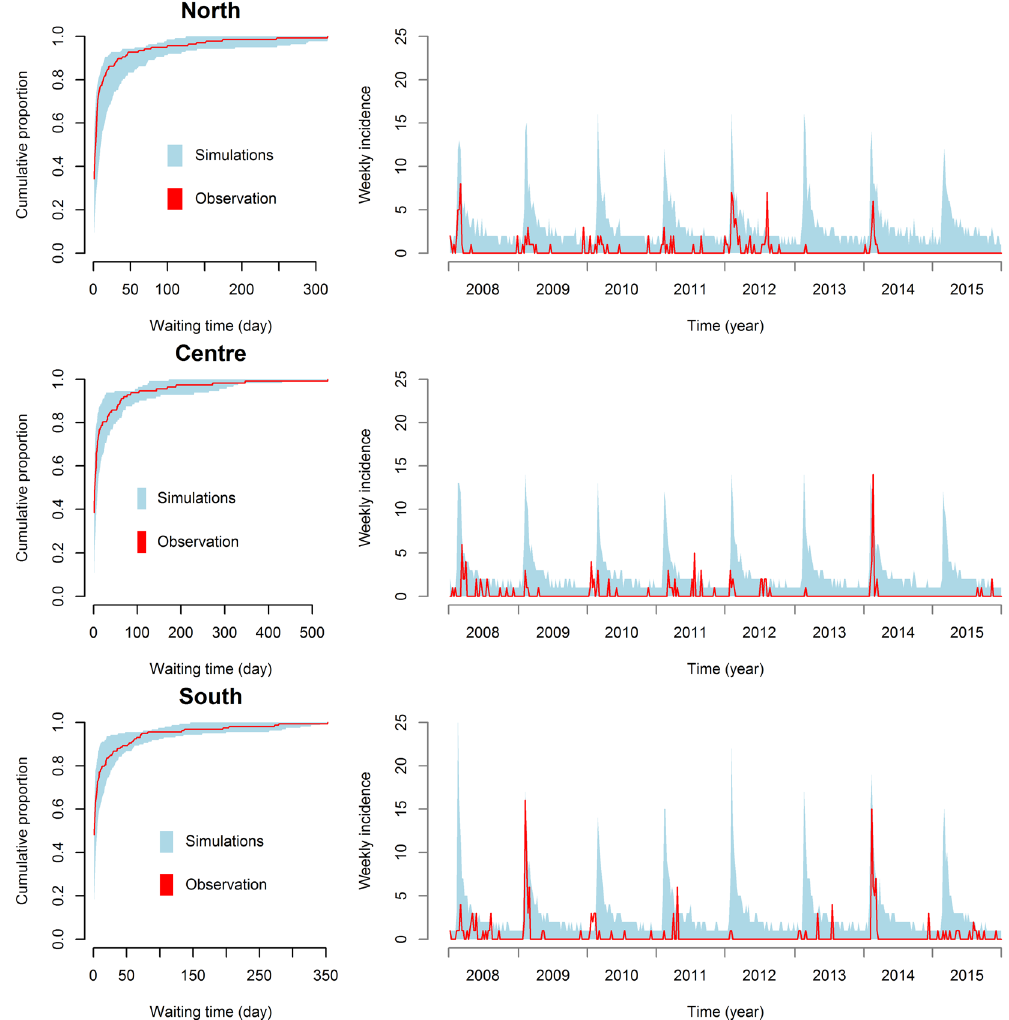
Figure 5. Results of the posterior predictive check in the 3 climatic regions of Vietnam. Observed and simulated cumulative distributions of AIO waiting times (Left) and observed and simulated AIO weekly incidence time series (Right). Parameters used: Duration of infectious period: 4 days; Time before repopulation: 15 days. Results obtained with other sets of fixed parameter values are displayed in Supplementary Fig.